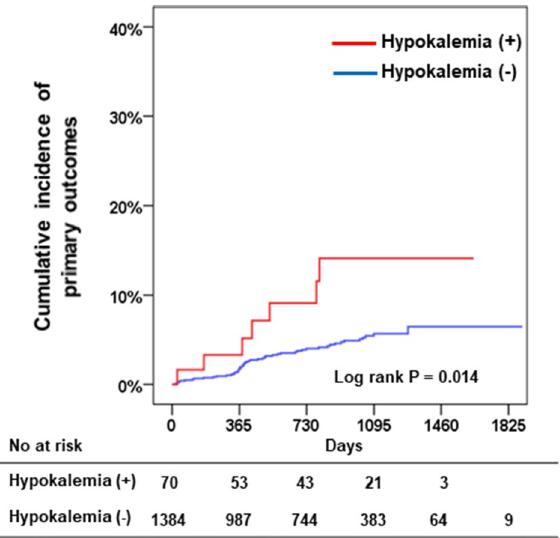
Figure 3. Cumulative incidence of primary outcomes between patients with and without hypokalaemia.